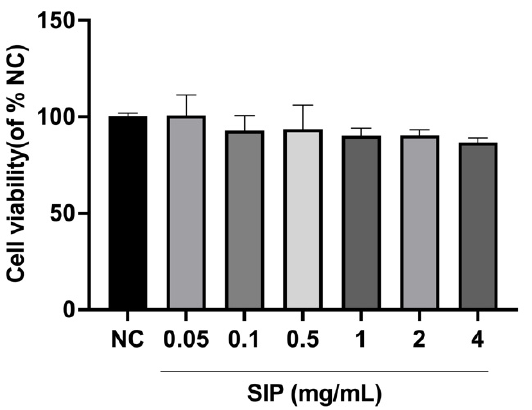
Figure 3. Effect of SIP on B16F10 cell viability. Results were presented as the mean ± SD ( n = 6).